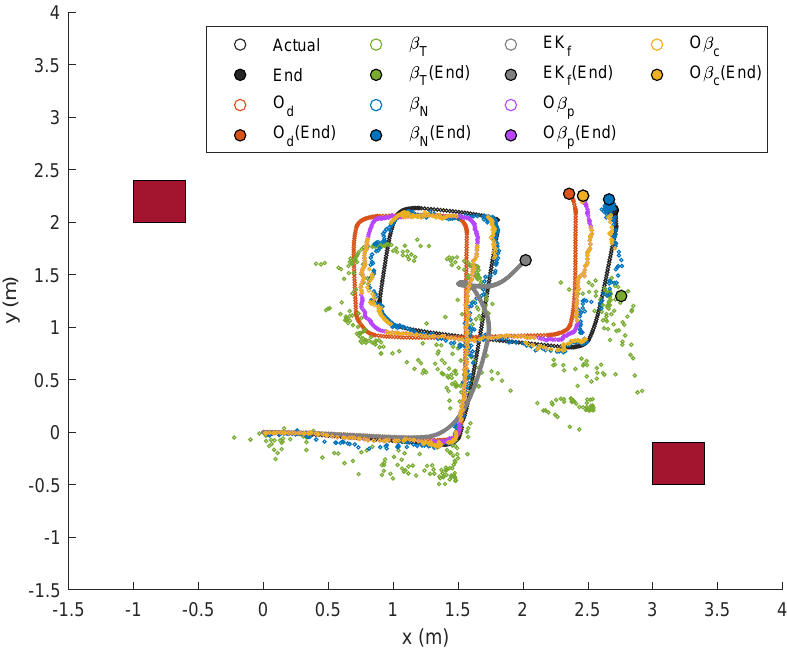
Figure 16. Localization of Node M in xy -plane in Trajectory